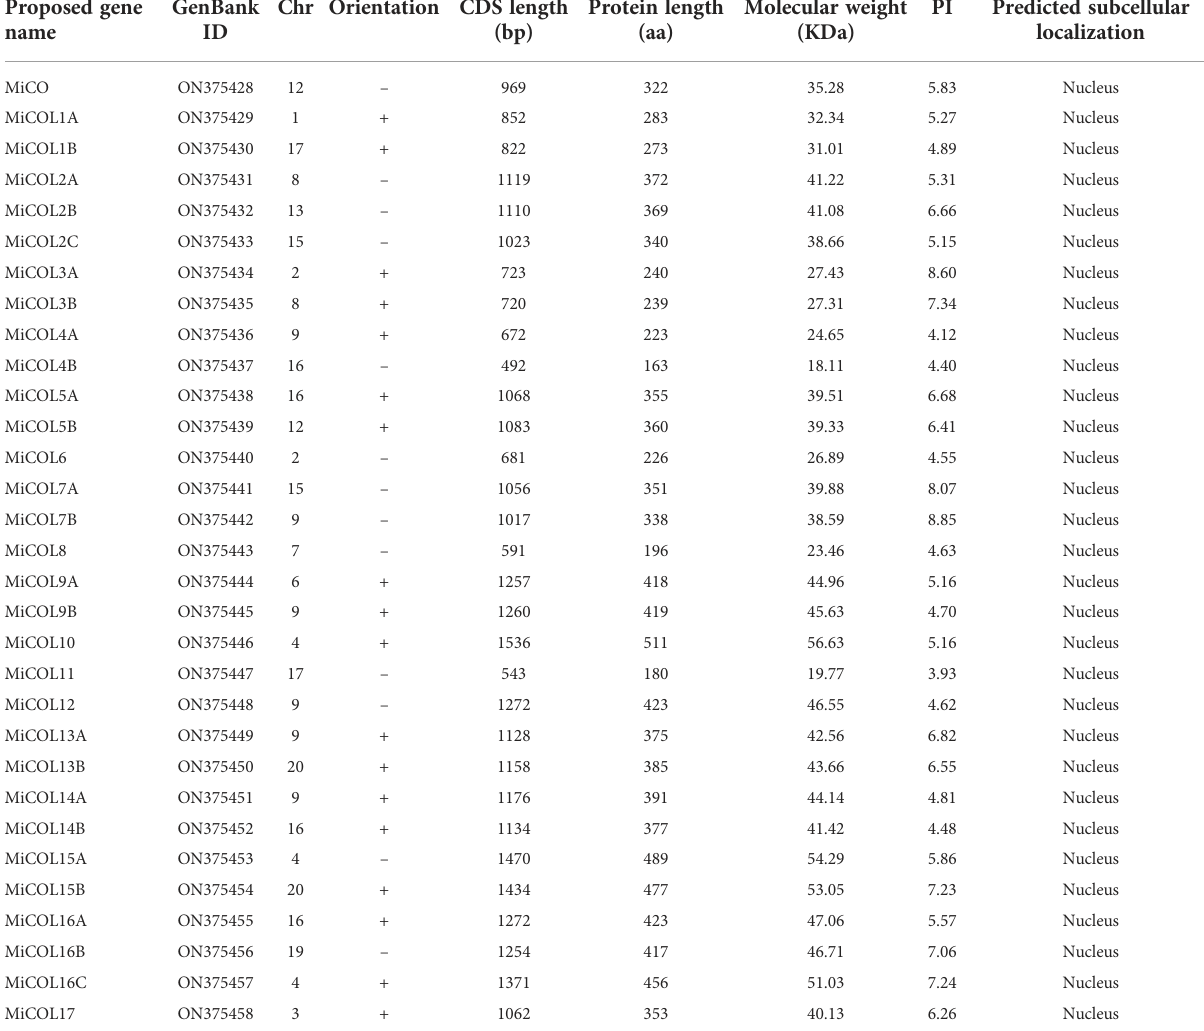
TABLE 1 Information concerning MiCO genes in